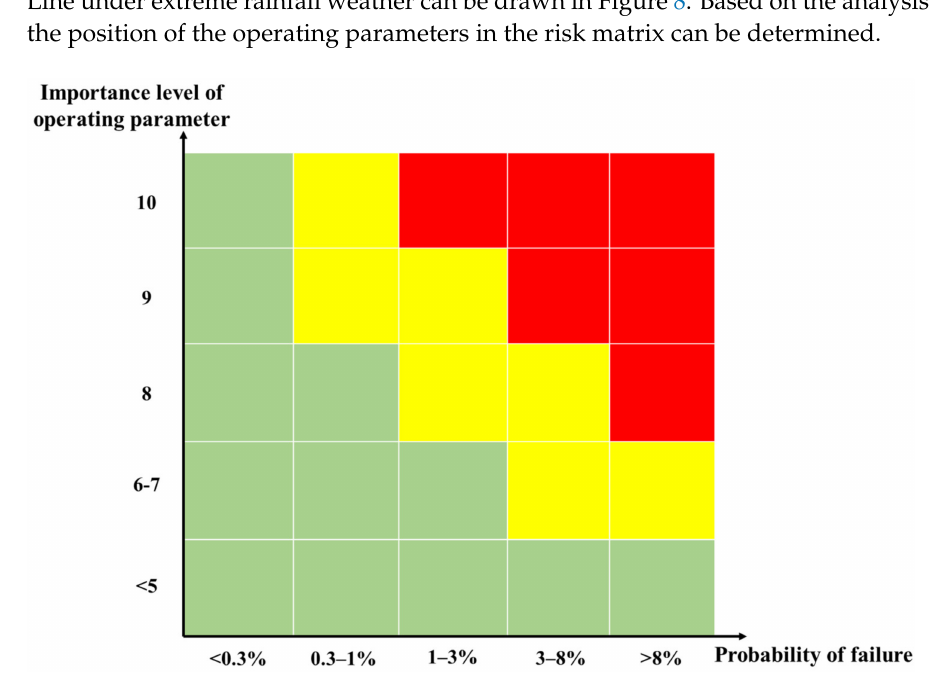
Figure 8. Risk matrix of the Changping